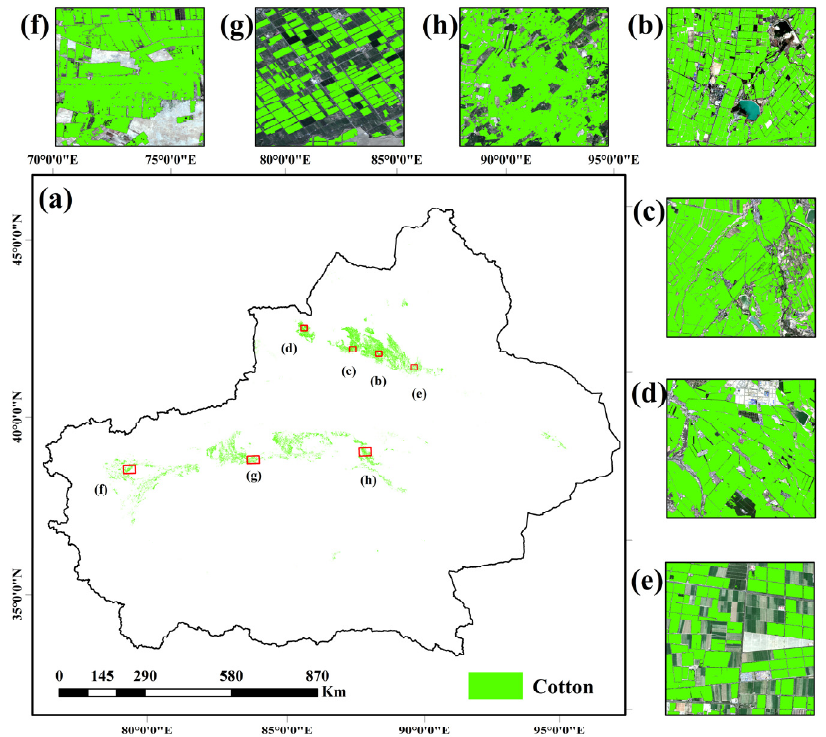
Figure 8. Spatial distribution of co tt on in Xinjiang. ( b – f ) represent the case regions. The speci fi c locations are marked in ( a ) with red boxes. Table 3. Confusion matrix of the co tt on map for Xinjiang.